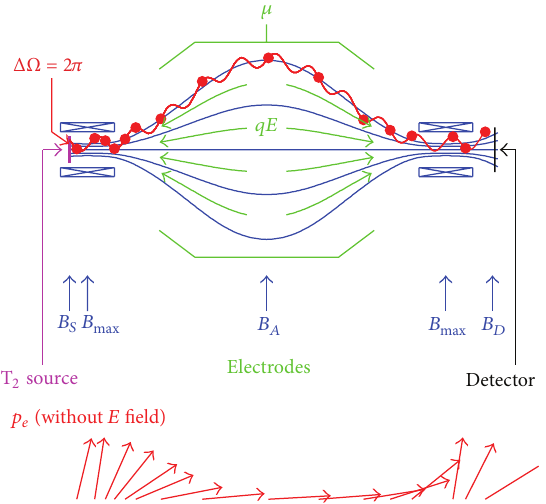
Figure 8: Principle of the MAC-E-Filter. Top: experimental setup, bottom: momentum transformation due to adiabatic invariance of the orbital magnetic momentum 𝜇 in the inhomogeneous magnetic